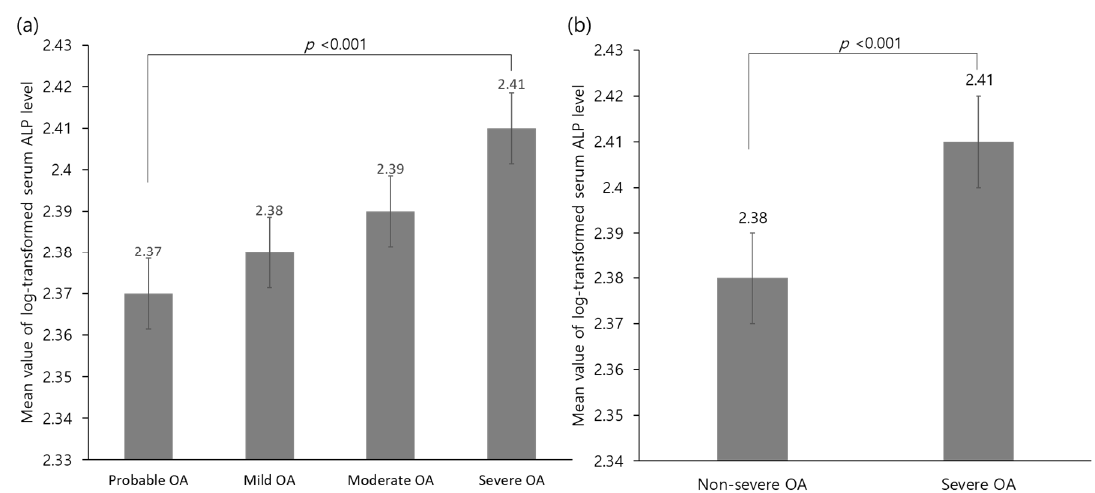
Figure 2. Comparison of the mean value of the log-transformed serum ALP levels according to ( a ) severity of OA or ( b ) between severe and non-severe OA. Abbreviations: ALP, alkaline phosphatase; OA, osteoarthritis.